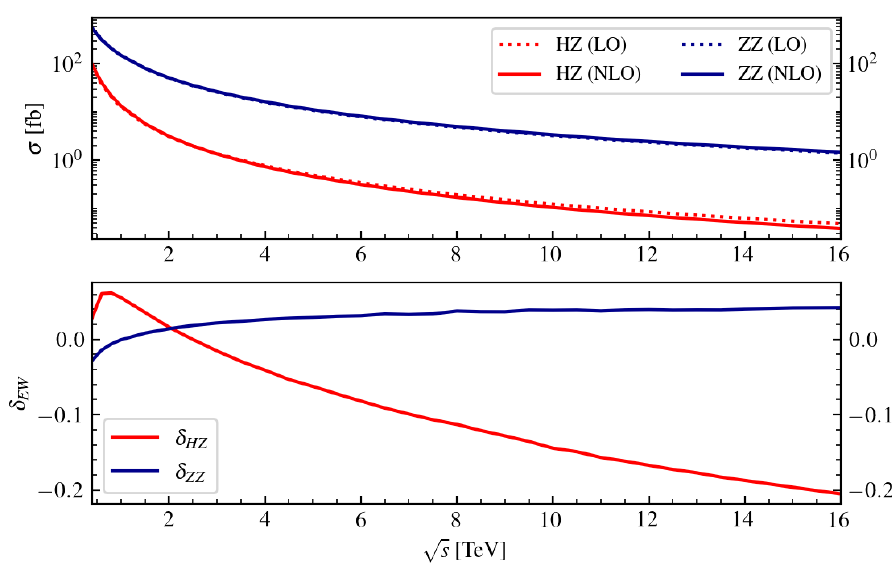
√ s for HZ and ZZ production in the upper